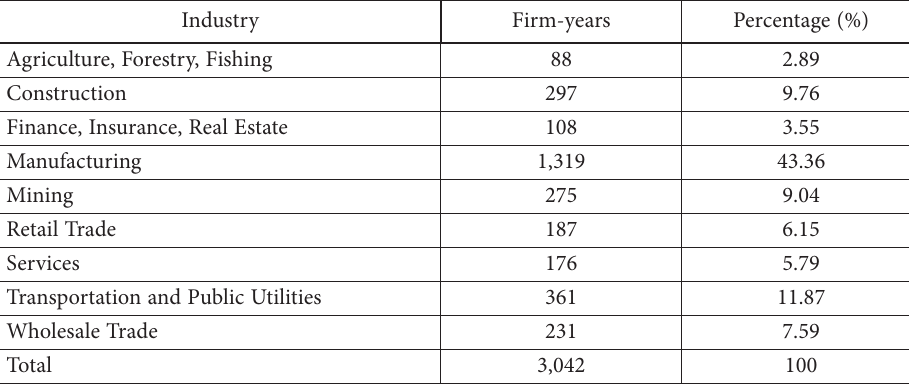
Table 1. Sample description by industry – PSM sample (source: author’s